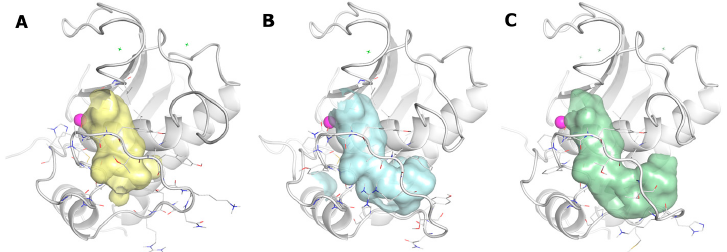
Figure 7. The molecular surface of the S1’ site of, ( A ) MMP-2 (pale yellow), ( B ) MMP-8 (pale cyan) and ( C ) MMP-13 (pale green) is depicted. MMP-2 has a tunnel-like S1’ site, while the MMP-8 and MMP-13 S1’ loop moves, opening an accessory pocket called the S1’ * site. However, the MMP-13 site is much larger, the MMP-8 site being hindered by the Arg222 side chain.